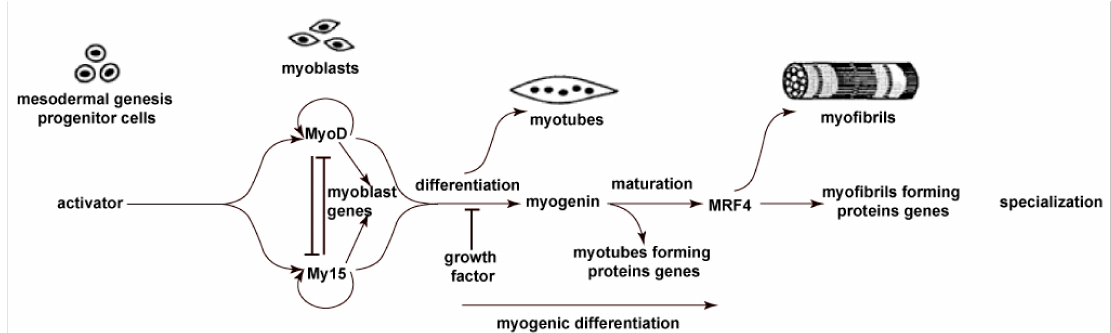
Figure 1. Transcription factors of myogenic differentiation and activation sequence. Reproduced with permission from Olson et al. [34]. Copyright 1994